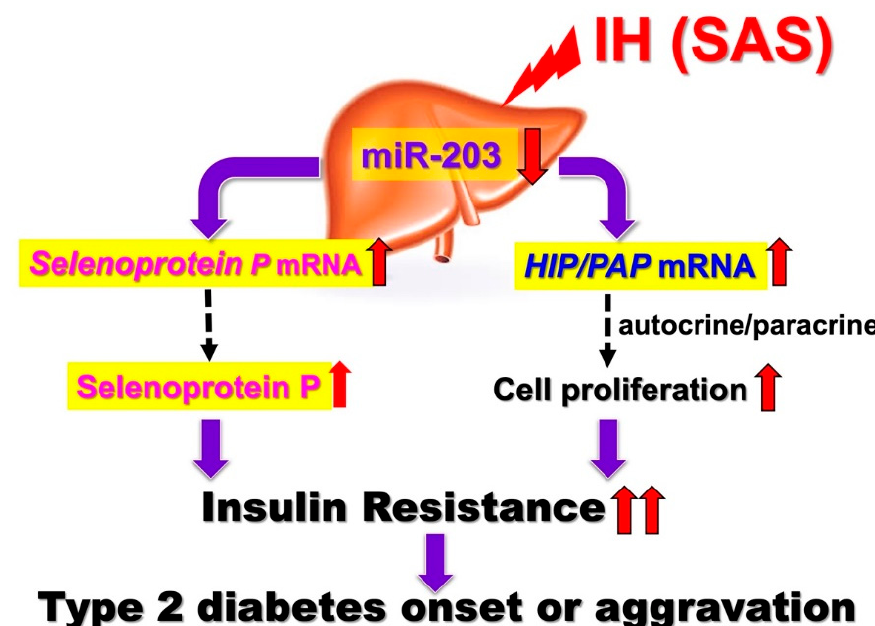
Figure 1. IH-induced upregulation of SeP and HIP/PAP via downregulation of miR-203. IH stress upregulates the levels of SeP in human hepatocytes to accelerate insulin resistance and upregulates the levels of HIP/PAP mRNAs to cause such hepatocytes to proliferate, via the miR-203 mediated mechanism. [5]. In SAS patients, it is suggested that the upregulation of SeP plays a role in worsening insulin resistance. In addition, overexpression of HIP/PAP could cause such hepatocytes to proliferate in SAS patients, leading to decreased insulin sensitivity. Red up and down arrows mean increment and decrease, respectively.